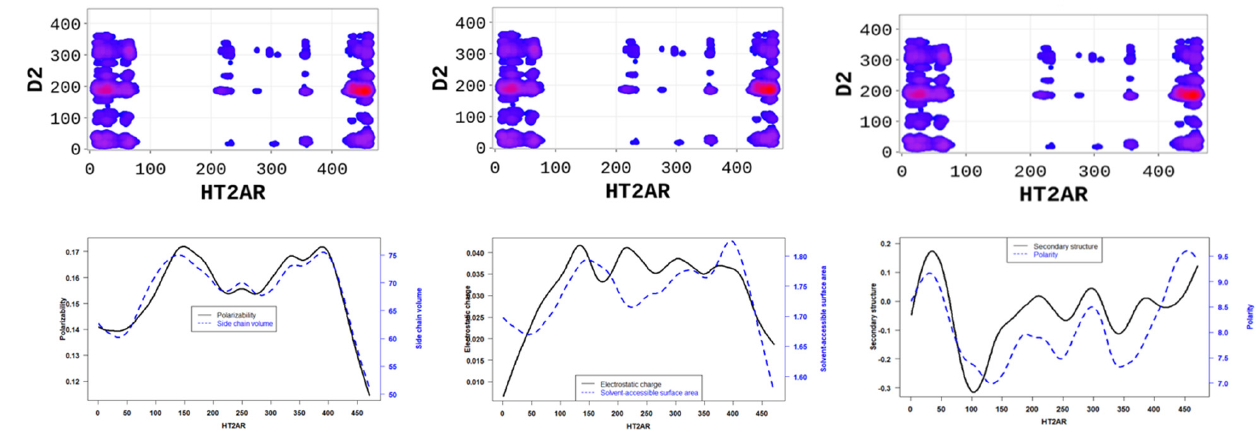
Figure 5. 5-HT2AR/D2R dimerization is mainly is driven by (1) the side chain volume and polarizability scores ( left panel ); (2) the electrostatic charge and solvent accessibility scores ( middle panel ); and (3) the secondary structure similarity (dominated by alpha-helix conformation) and polarity scores ( right panel ) of 5-HT2AR